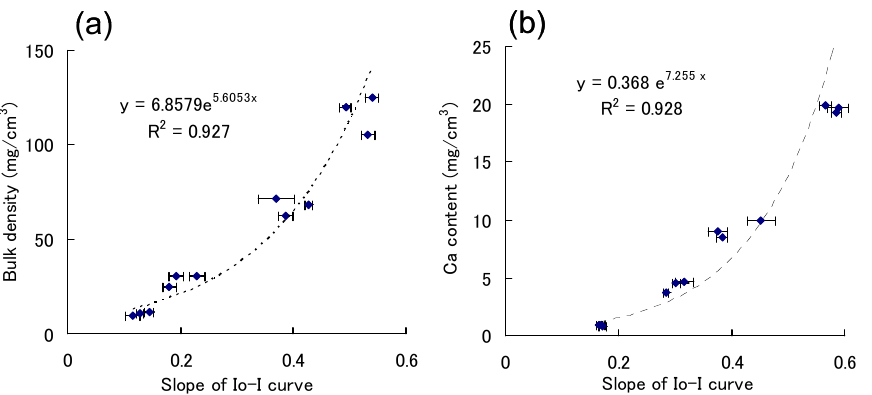
Fig. 2 (a) I -I curve with a slope representing the degree of calcification. (b) Typical I-I 0 curves for HA-deposited collagen sponges with varied bulk density and a compact bone sample with a 2-mm thickness, taken from a bovine femur.